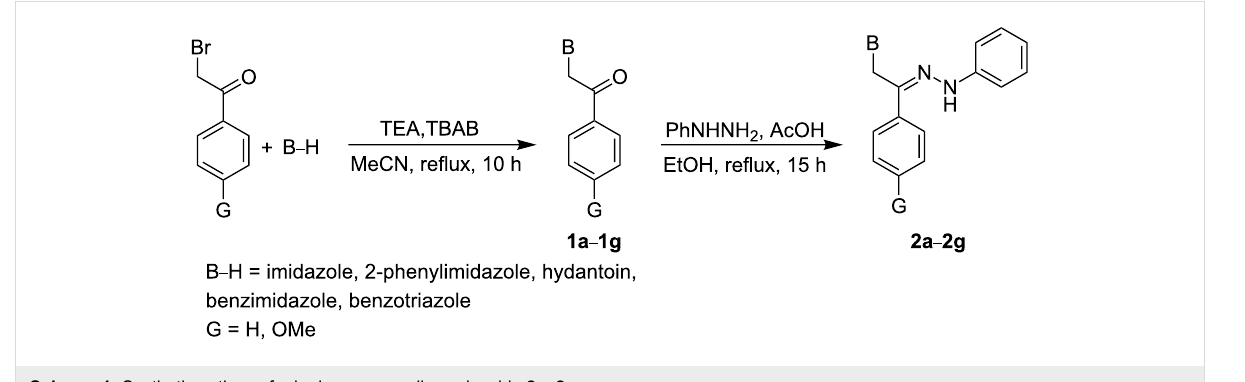
Scheme 1: Synthetic pathway for hydrazono acyclic nucleoside 2a – 2g .